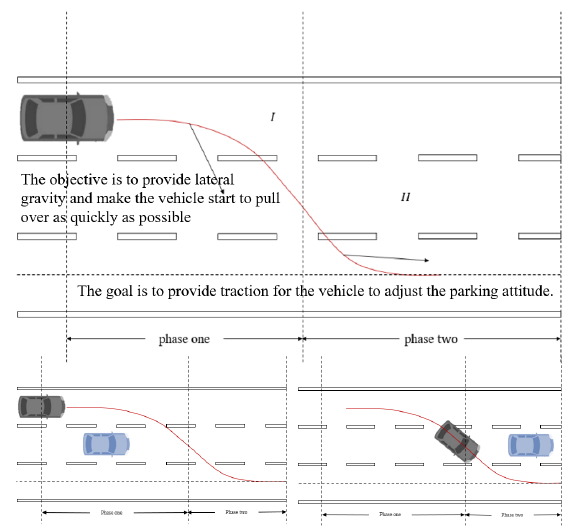
Figure 11. Analysis of variable target thought.